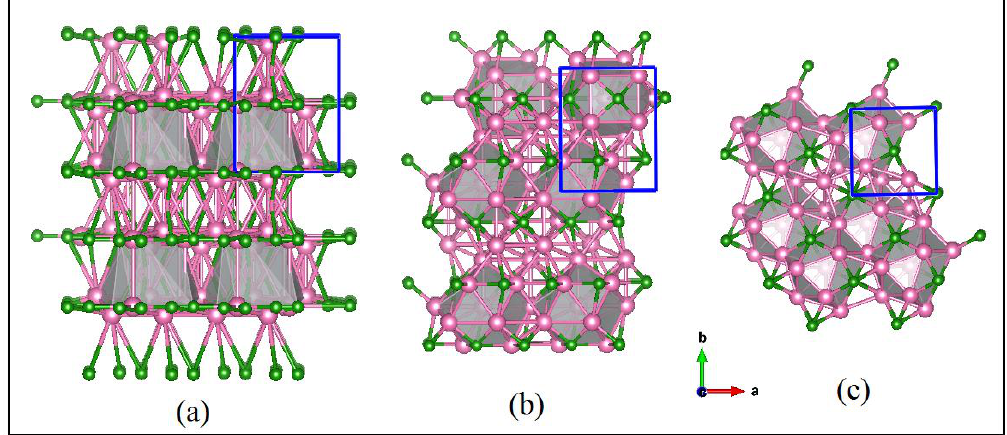
Figure 1. Crystal structures of ( a ) Orthorhombic Ni 4 B 3 , ( b ) Ni 3 B and ( c ) Ni 2 B. Unit cells are outlined in blue. Ni atoms are pink and B atoms are green.